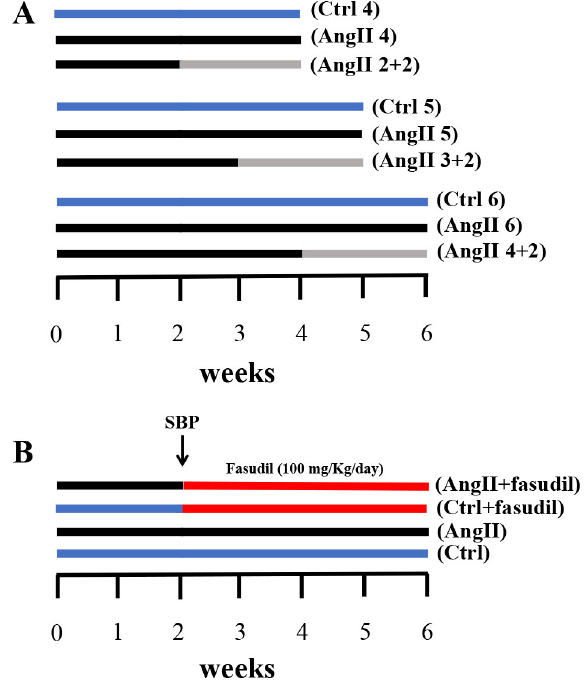
Figure 1. Outlines of experimental protocols developed in male Sprague Dawley rats. ( A ) We used three experimental groups that were evaluated at 4, 5 and 6 weeks, respectively. Each group was divided into three subgroups: one control Ctrl (blue line); another with AngII infusion (160 ng / min, black line) during 4, 5 and 6 weeks (AngII 4, AngII 5 and AngII 6); and a third one in which animals were treated with AngII for 2, 3 and 4 weeks and then the treatment was suspended for the next 2 weeks (AngII 2 + 2, AngII 3 + 2 and AngII 4 + 2, grey line). ( B ) Four experimental groups were used; these were divided into two control groups and two groups with AngII administration for 6 weeks. At 2 weeks after the initiation of the administration of AngII, systolic blood pressure (SBP) was measured and the groups were subdivided into rats treated with Fasudil (100 mg / kg / day) (AngII + Fasudil) (Ctrl + Fasudil) for 4 weeks (red line) and rats that continued to be treated with only AngII until completing 6 weeks (AngII) and their controls (Ctrl).